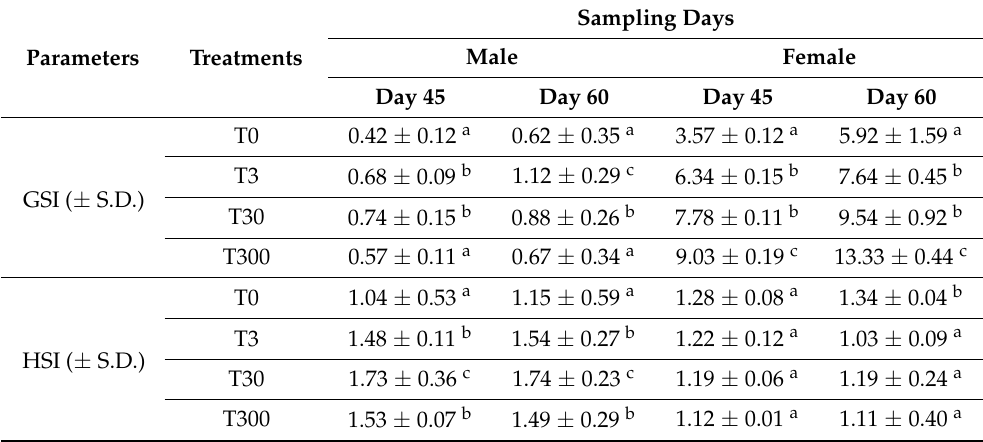
Table 1. Changes in GSI and HSI of climbing perch exposed to different concentrations of ethinylestra- diol/desogestrel mixtures.